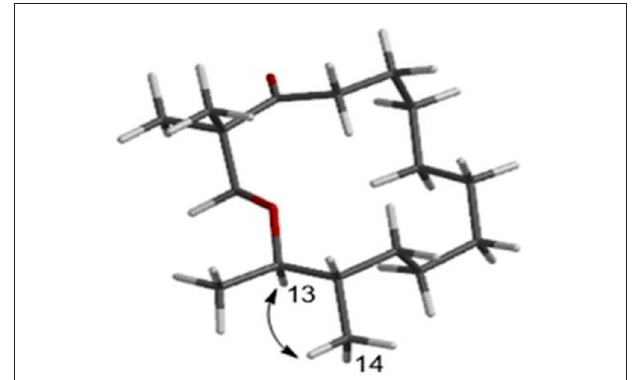
FIGURE 4 | NOESY correlation of